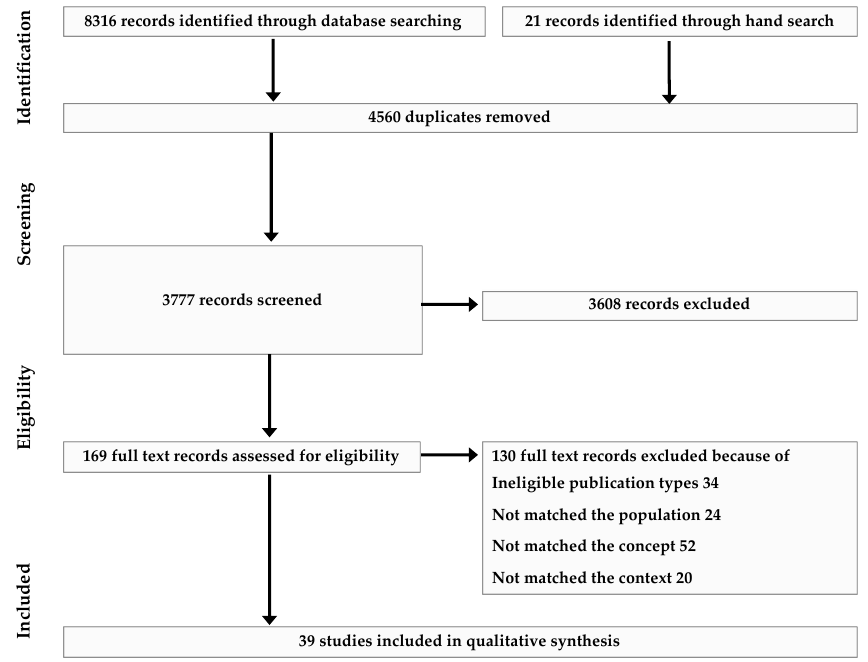
Figure 1. The selection process in PRISMA flow diagram.